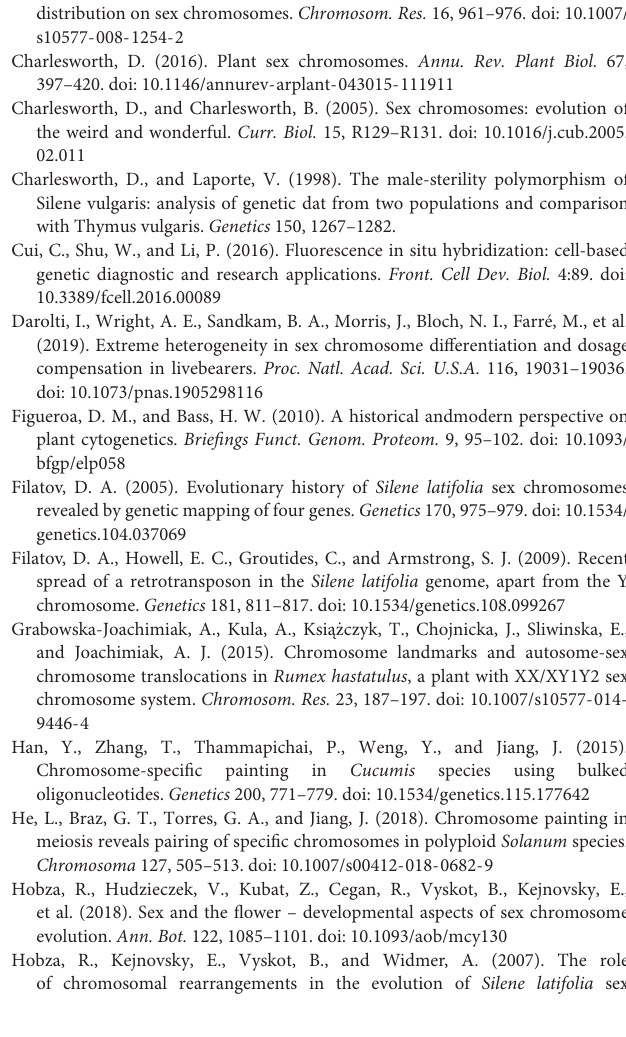
S. dioica . Note the distribution of STAR-C in S. vulgaris and S. maritima . Scale bar = 10 µ m. FIGURE S3 | Distribution of X chromosome-specific oligo probe on prophase and early metaphase chromosomes in S. latifolia , S. dioica , S. vulgaris and S. maritima . 12 988 has coverage 2.5–3 oligo sequences/kb, reaching 1.8–5.5 oligo sequences/kb on selected loci. Oligo painting probe (in red) hybridizes to very end of X and Y chromosomes in (sub)telomeres in S. latifolia and S. dioica . In S. vulgaris and S. maritima , the oligo painting probe labels six pairs of autosomes, hybridizing to their p-arm. Although the signal strength is weaker compared to condensed metaphase chromosomes, the oligo painting probe clearly marks sex chromosomes and autosomes in all studied species. Scale bar = 10 µ m. FIGURE S4 | Distribution of the oligo painting probe in S. latifolia and S. dioica female karyotype. Oligo painting probe was hybridized on metaphase chromosomes and on interphase nuclei in S. latifolia (a,c) and in S. dioica (b,d) . The remnant of a cytoplasm (signal not attached to any chromosome) is visible in the bottom of the S. dioica (b) . Scale bar = 10 µ m. TABLE S1 | Plant material. TABLE S2 | Oligo probe sequence scaffolds ID. TABLE S3 | The composition of the enzyme mix and hybridisation